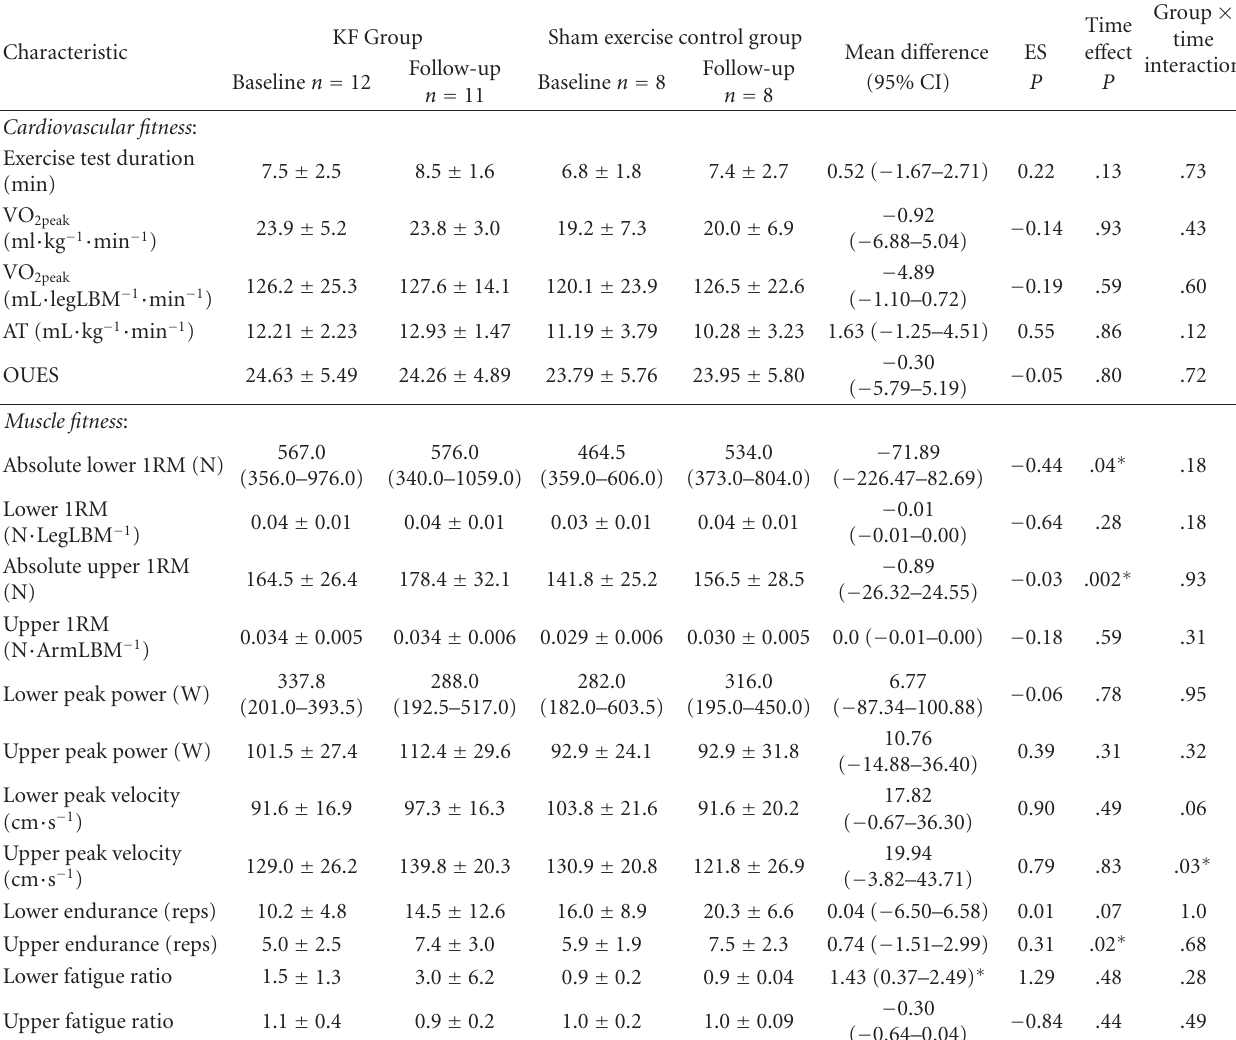
Table 1: Outcomes, physical